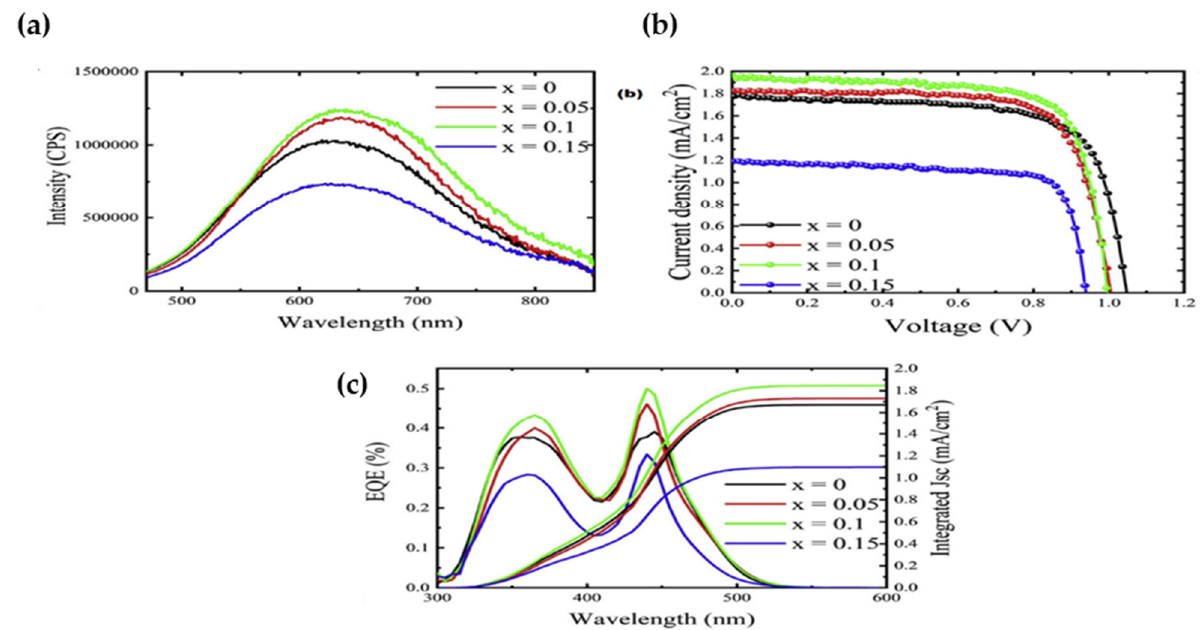
Figure 16. ( a ) The PL spectra of (Cs 1 − x Rb x ) 2 AgBi 6 films on quartz; ( b ) The J-V curves of the champion devices with (Cs 1−x Rb x ) 2 AgBi 6 and ( c ) the EQE and IPEC of the devices. Reproduced with permission from [84] . Copyright 2019, Elsevier.